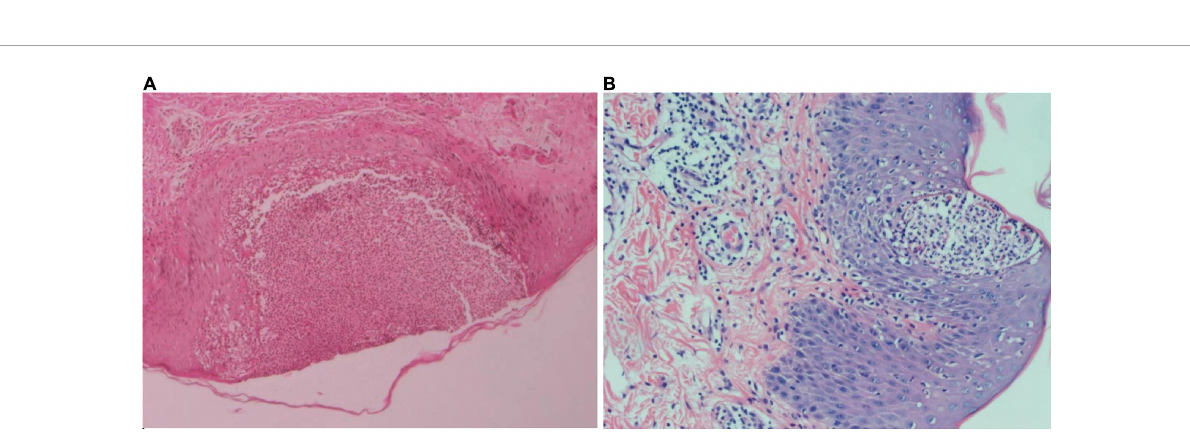
FIGURE2 (A) Skin biopsy of the left lower limb with hematoxylin-eosin staining at 50 × magnification. Squamous epithelial hyperplasia was observed with epidermal pustular formations. Kogoj abscesses can be seen at the pustular margin. The upper dermis showed lymphocytic infiltration and some dermal papillary edema. Perivascular infiltration and a small number of lymphocytes were also observed. (B) Skin biopsy of the left lumbar region with hematoxylin and eosin staining at 100 × magnification. Squamous epithelial hyperplasia, Munro micro abscesses, and Kogoj abscesses were observed in the epidermis. A small amount of lymphocytic and neutrophilic infiltrate was observed in the upper dermis. Some dermal papillary edema, vascular dilation hyperemia and lymphocytic perivascular infiltration was also observed.